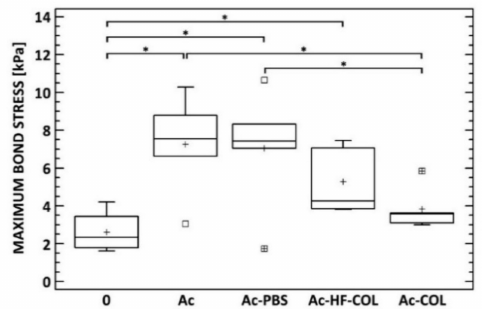
Figure 7. Box-plot of maximum bond stress required for separation of COL / HAp layer from di ff erently treated titanium surfaces. * denotes statistically significant di ff erences (Fisher’s LSD test,